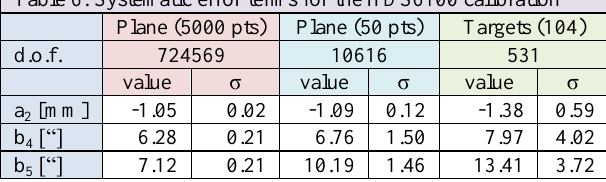
Table 6: Systematic error terms for the HDS6100 calibration Plane (5000 pts) Plane (50 pts) Targets